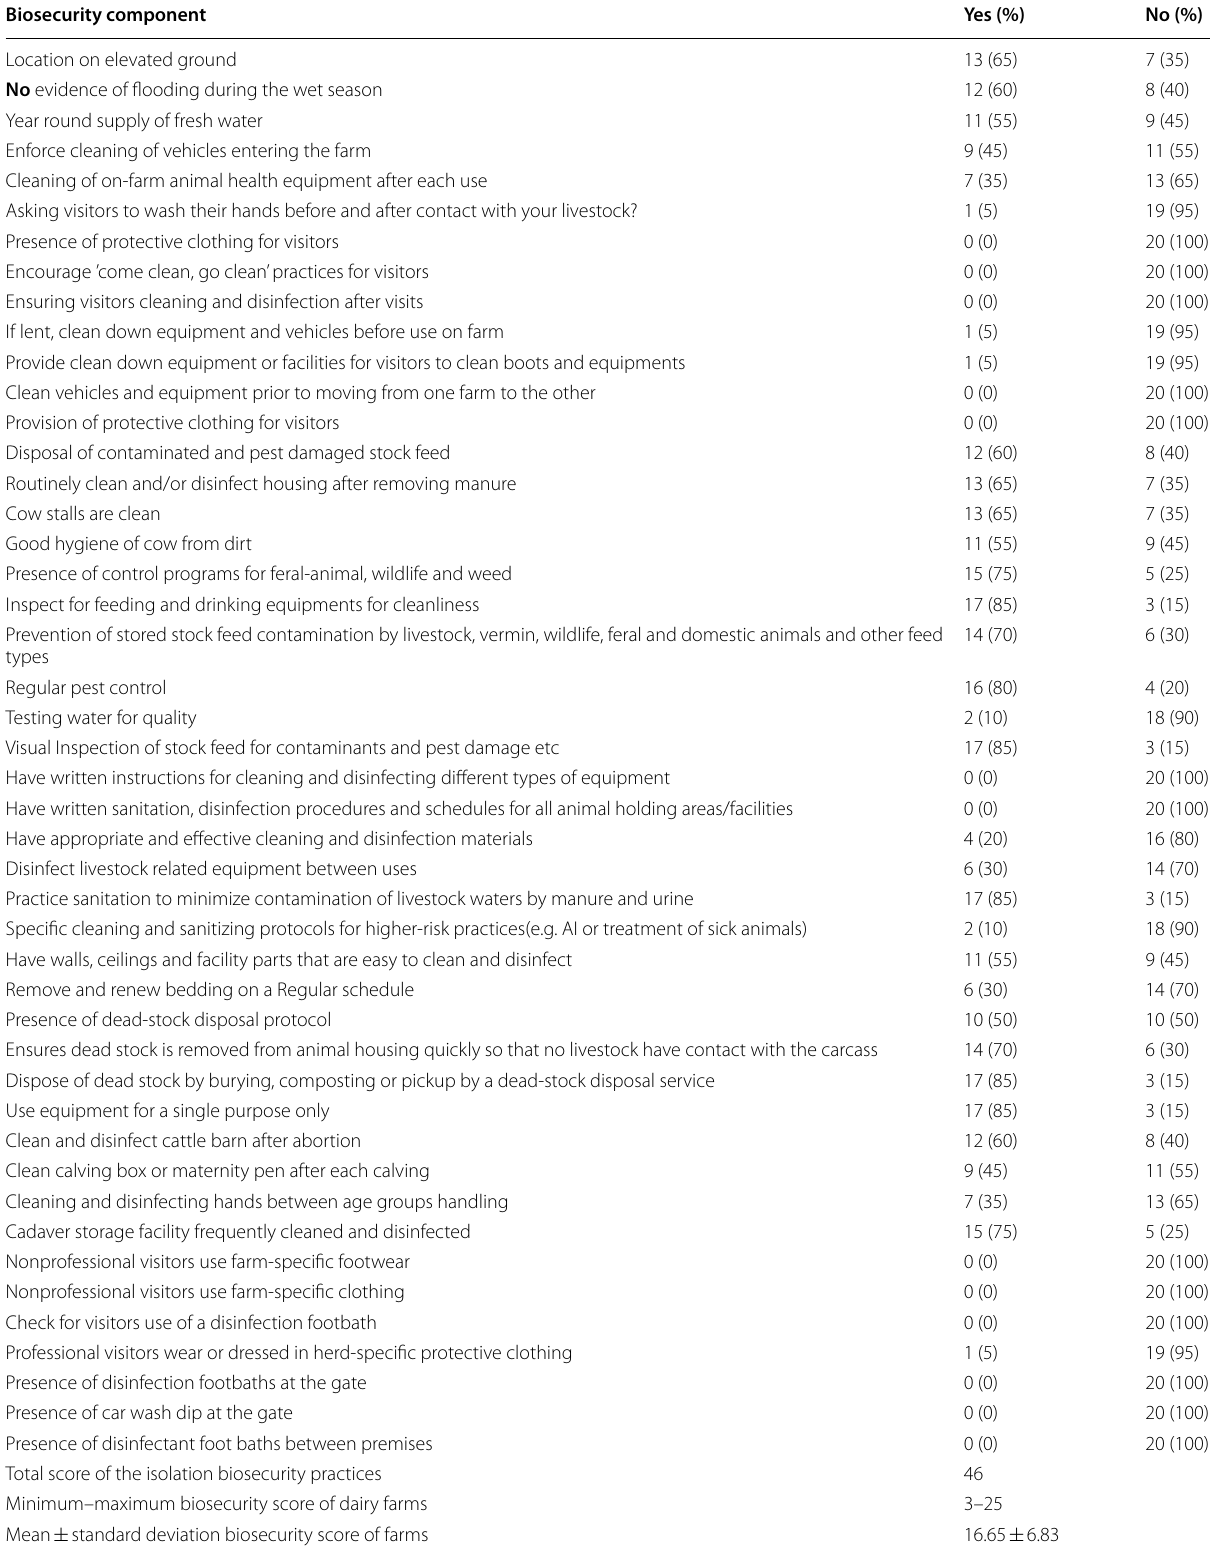
Table 6 Percentage practices of sanitation biosecurity component Biosecurity